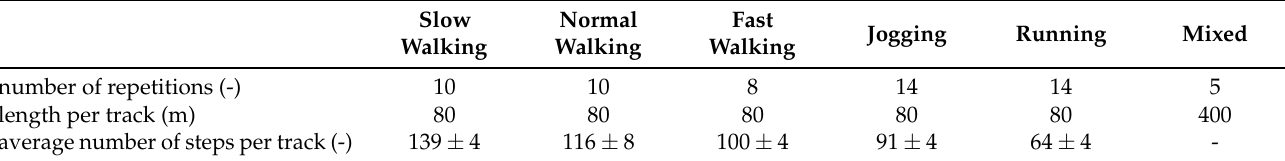
Table 2. Overview of collected